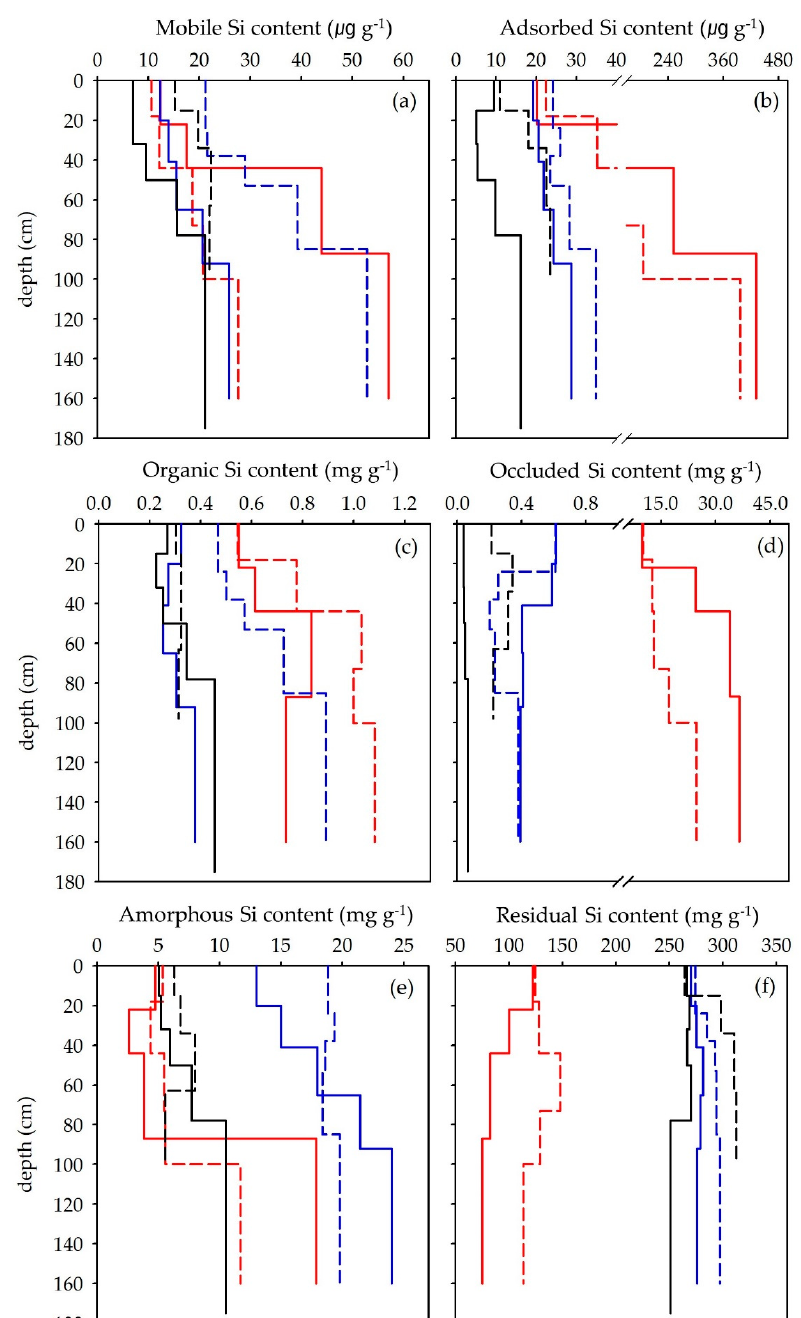
Figure 3. Depth fractionation of silicon in Jeju Island [Andisols; Noro (solid red), Pyeongdae (dashed red), Ultisols; Jeju (solid blue), and Alfisols; Gangjeong (dashed blue)] and Korean mainland forest soils [Inceptisols; Samgag (solid black) and Oesan (dashed black)] according to sequential extraction. ( a ) mobile Si, ( b ) adsorbed Si, ( c ) Si bound to soil organic matter, ( d ) Si occluded in pedogenic oxides and hydroxides, ( e ) Si in total amorphous silica, and ( f ) residual Si in crystalline silicates.